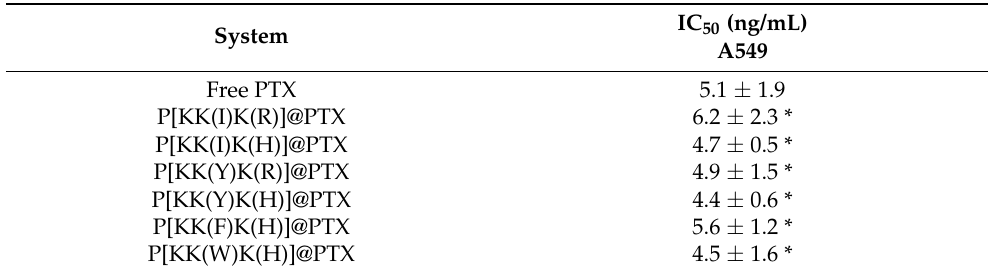
Table 5. Values of IC 50 determined for various PTX-loaded polypeptide particles incubated with cancer cells (A549 cell line, MTT, 72